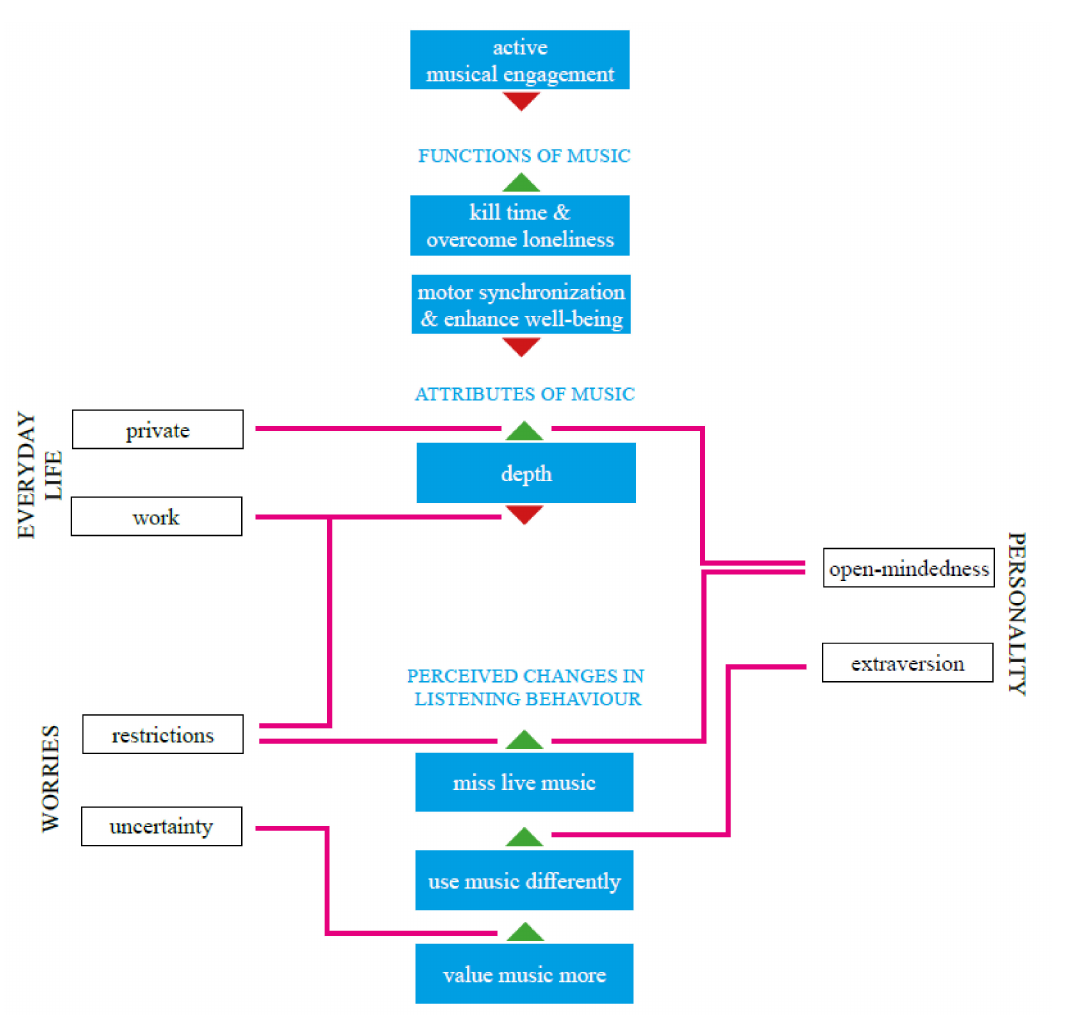
Figure 1. Changes in musical behavior during the lockdown and effects of worries, everyday life, and